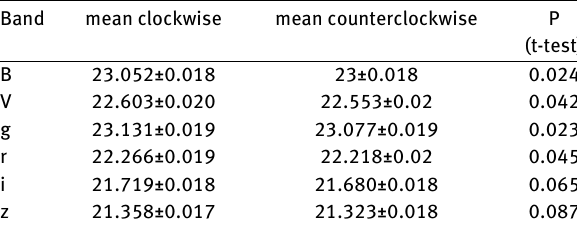
Figure 1. Histograms of the V magnitude and the photometric red- shift of the clockwise and counterclockwise galaxies in the dataset. Table 1. Mean, standard error of the mean, and the one-tail sta- tistical significance of the differences between the magnitude of clockwise galaxies and counterclockwise galaxies in